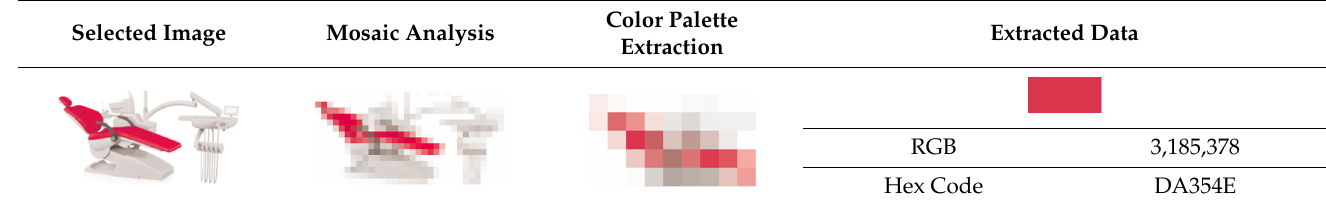
Table 3. Color data extraction method.